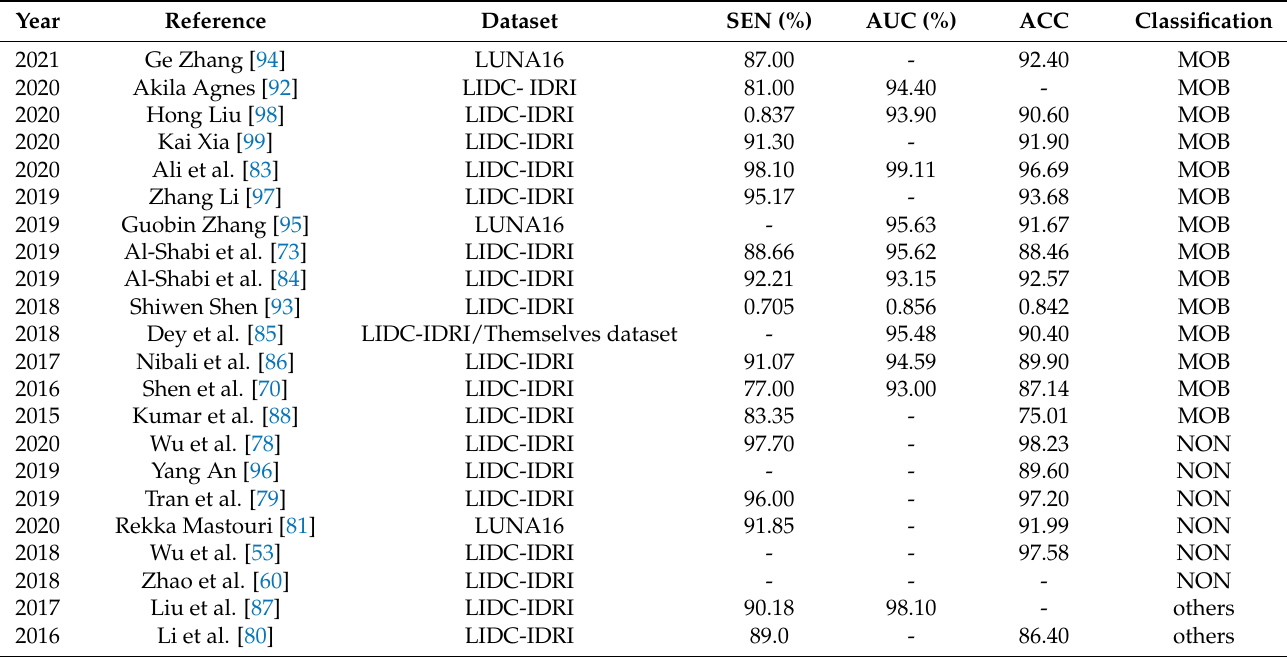
Table 6. Results comparison of nodule classification